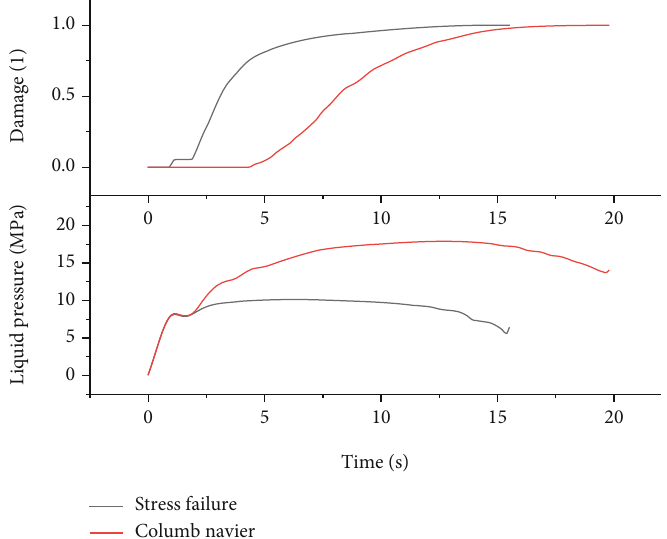
Figure 14: Damage and fl uid pressure pro fi les at the geometric center point for the principal stress criterion and the Coulomb-Navier